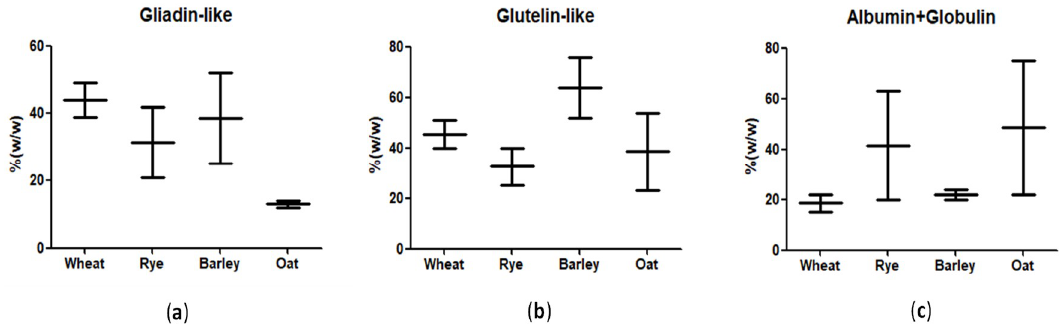
Figure 1. Relative content in gluten proteins of the most consumed cereals expressed as medium average content found in literature (%). ( a ) Gliadin-like proteins; ( b ) Glutelin-like proteins; ( c ) Albumin + Globulin proteins [8–12].